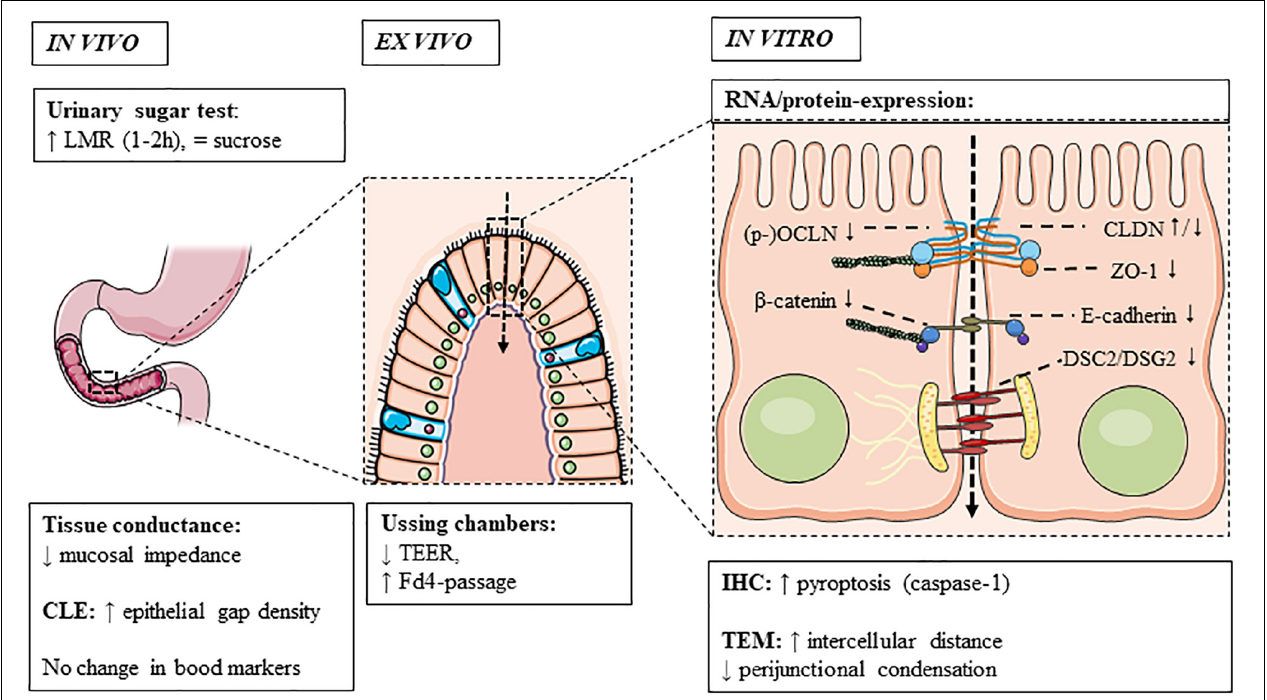
FIGURE 3 | Duodenal permeability in functional dyspepsia. Increased permeability is observed in functional dyspepsia using in vivo and ex vivo techniques and associated with a dysregulation of cell-to-cell adhesion proteins, of which the main findings are summarized. CLDN, claudin; CLE, confocal laser endomicroscopy; Fd4, fluorescein isothiocyanate-labeled 4 kDa dextran; IHC, immunohistochemistry; OCLN, occludin; TEER, transepithelial electrical resistance; TEM, transmission electron microscopy; ZO,